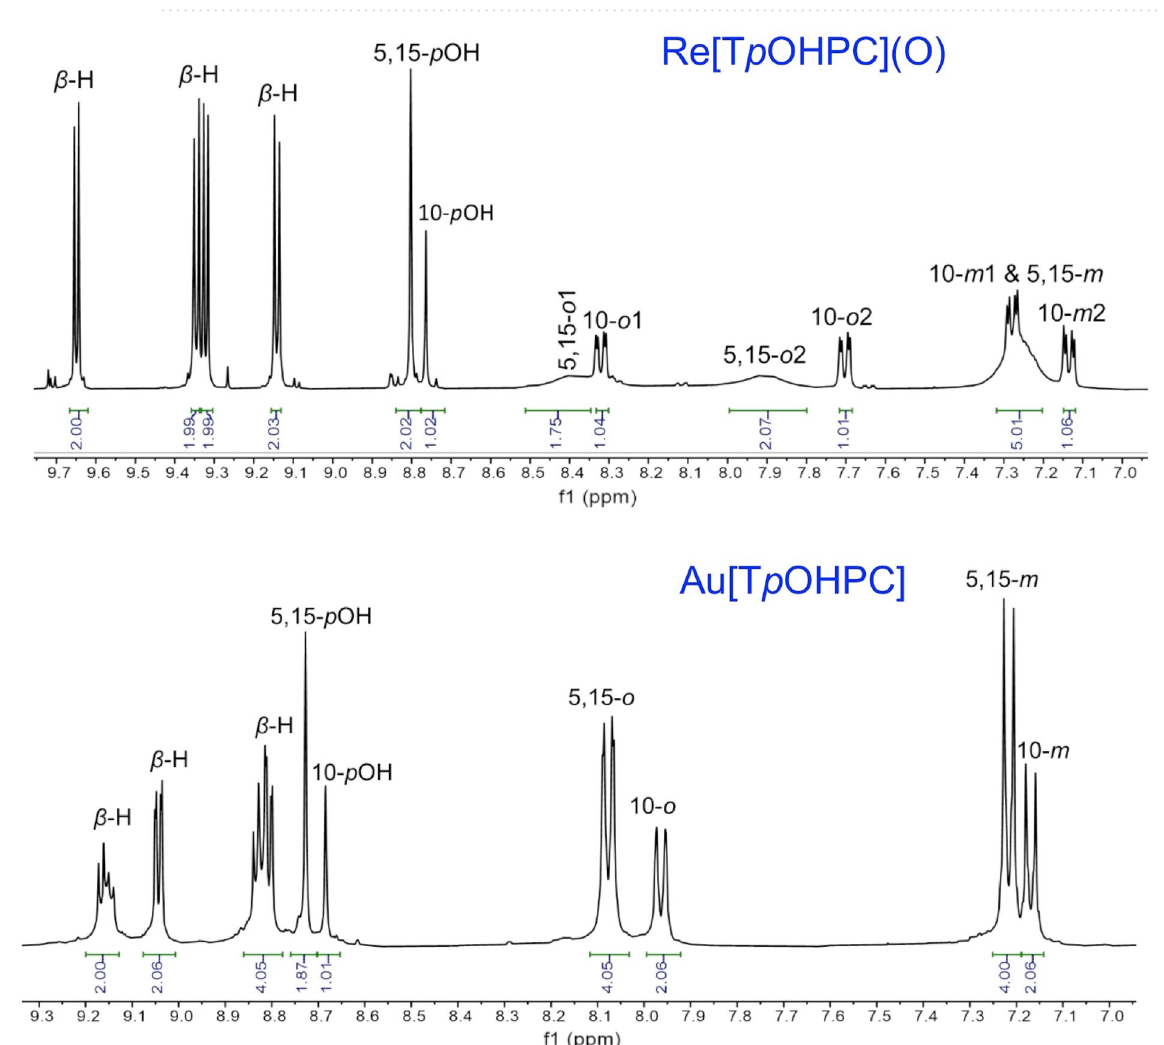
Figure 2. 1 H NMR spectra of M[T p OHPC] in THF- d 8 : M = ReO (above) and Au